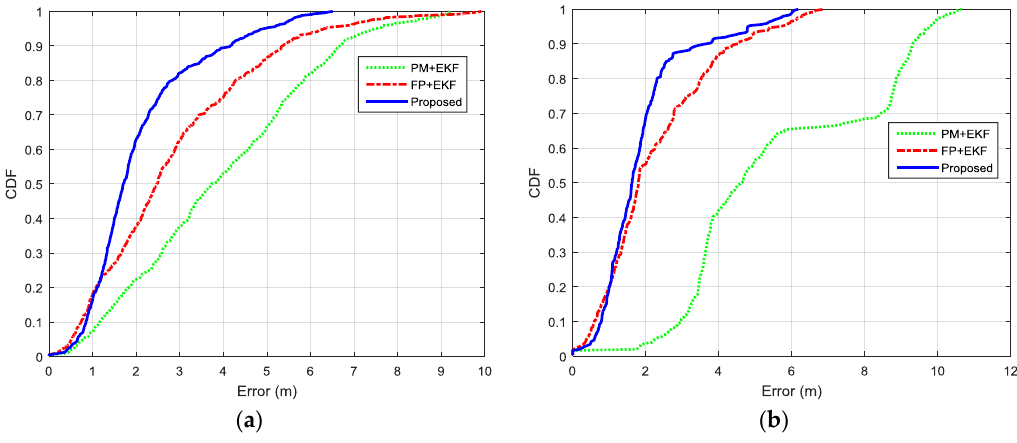
Figure 17. CDFs of localization errors of the two indoor trajectories with sparsely distributed BLE beacons using the proposed method, PM + EKF and FP + EKF: ( a ) Trajectory I; and ( b ) Trajectory II.